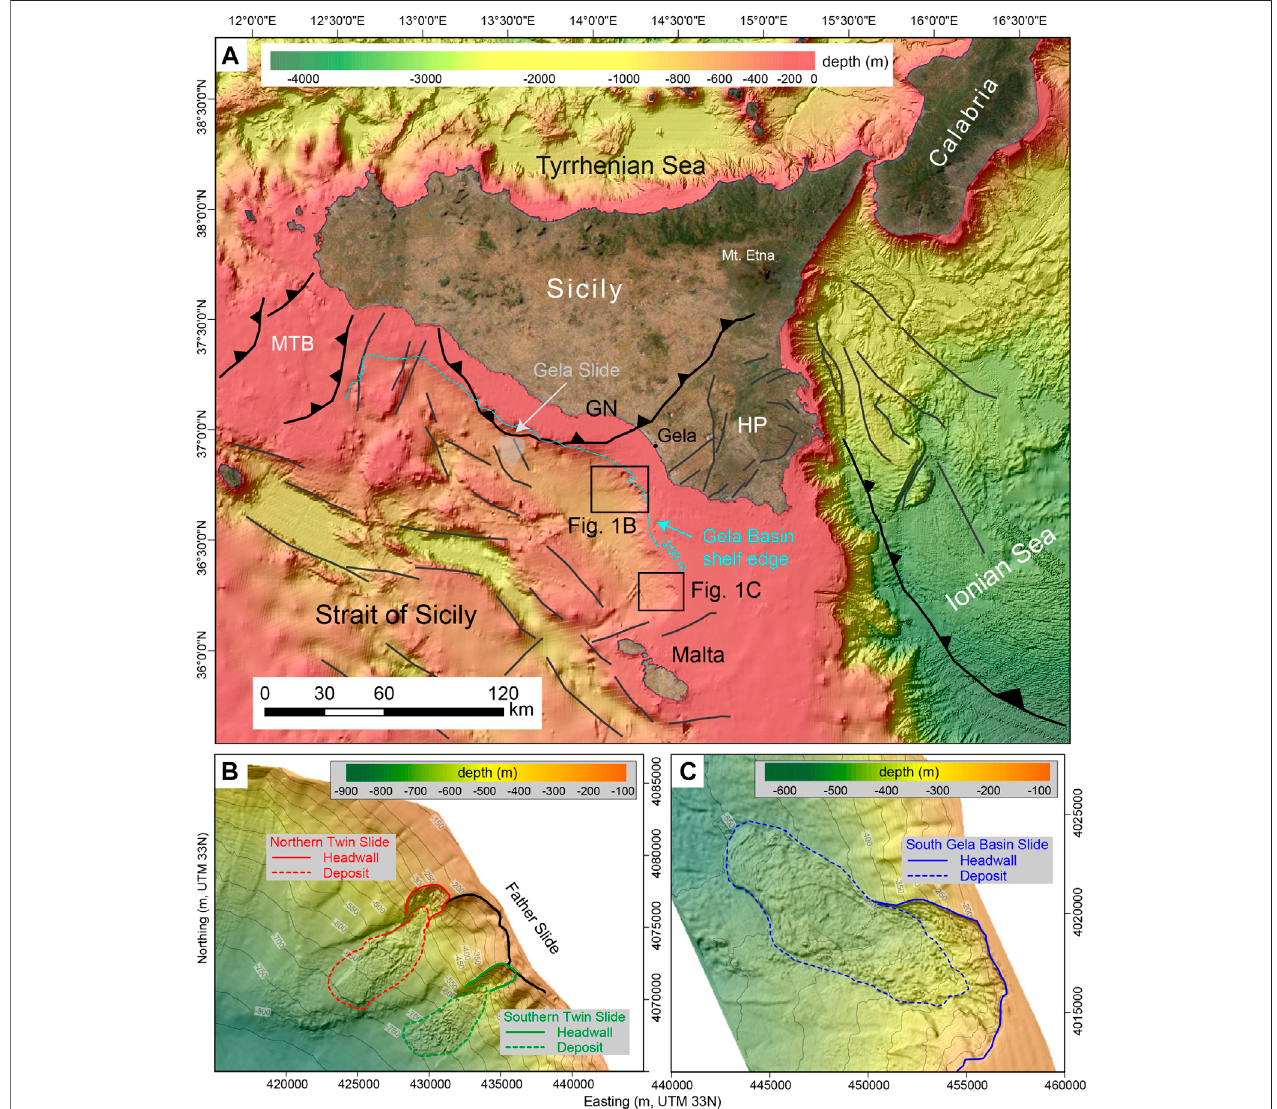
FIGURE1|(A) Simpli fi edstructuralsketchoftheStraitofSicily and adjacent regionswith theshelf-edge oftheGela Basineastern slope(GBES) highlighted bythe 200 m isobath (in light blue). Structural elements adapted from various sources (mainly Argnani et al., 1987; Argnani et al., 2012). Bathymetric data are from EMODnet (EMODnetBathymetryConsortium,2018).MTB (cid:2) MaghrebianThrustBelt,GN (cid:2) GelaNappe,HP (cid:2) HybleanPlateau. (B) Zoomonthenorth-easternsectoroftheGBES, highlightingtheTwinSlidescomplexandthedifferentslidefeatures.Theblacklinemarksthe “ FatherSlide ” headwall,theredandgreenonesareforthesubsequent NTS and STS headwalls, respectively. At the toe of the scarps, the deposits of the two slides are shown with the red-dashed and green-dashed lines, respectively. (C) ZoomonthesouthernsectoroftheGBES.ThebluelinemarkstheSBGSheadwall,atabout200 mdepth,whilethedashed-bluelinedelimitstheslidedeposit,atthetoe of the